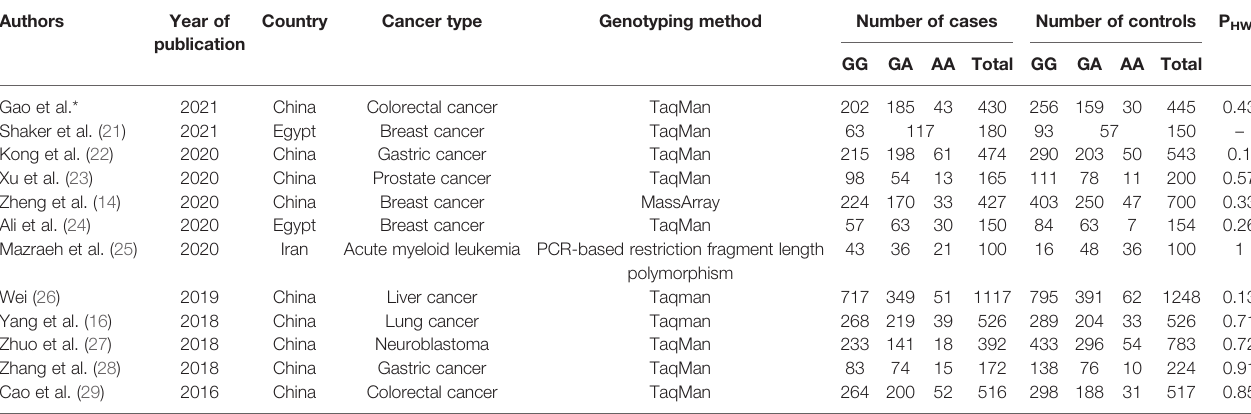
TABLE 2 | Main characteristics of the case-control studies in the current